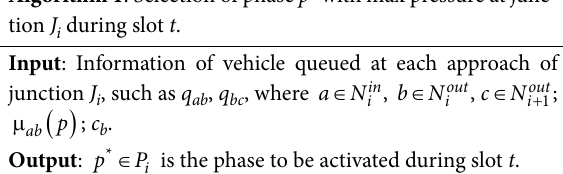
Table 1. Explication of the Algorithm 1 Algorithm 1 : Selection of phase p * with max pressure at junc- tion J i during slot t